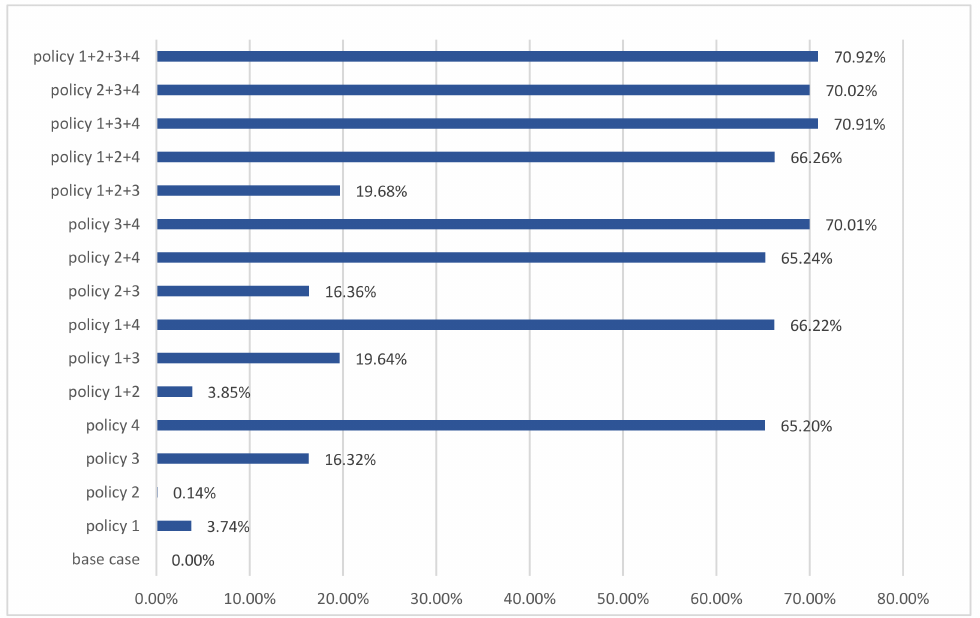
Figure 6. The effect of policy measures on the environmental impacts stocks until